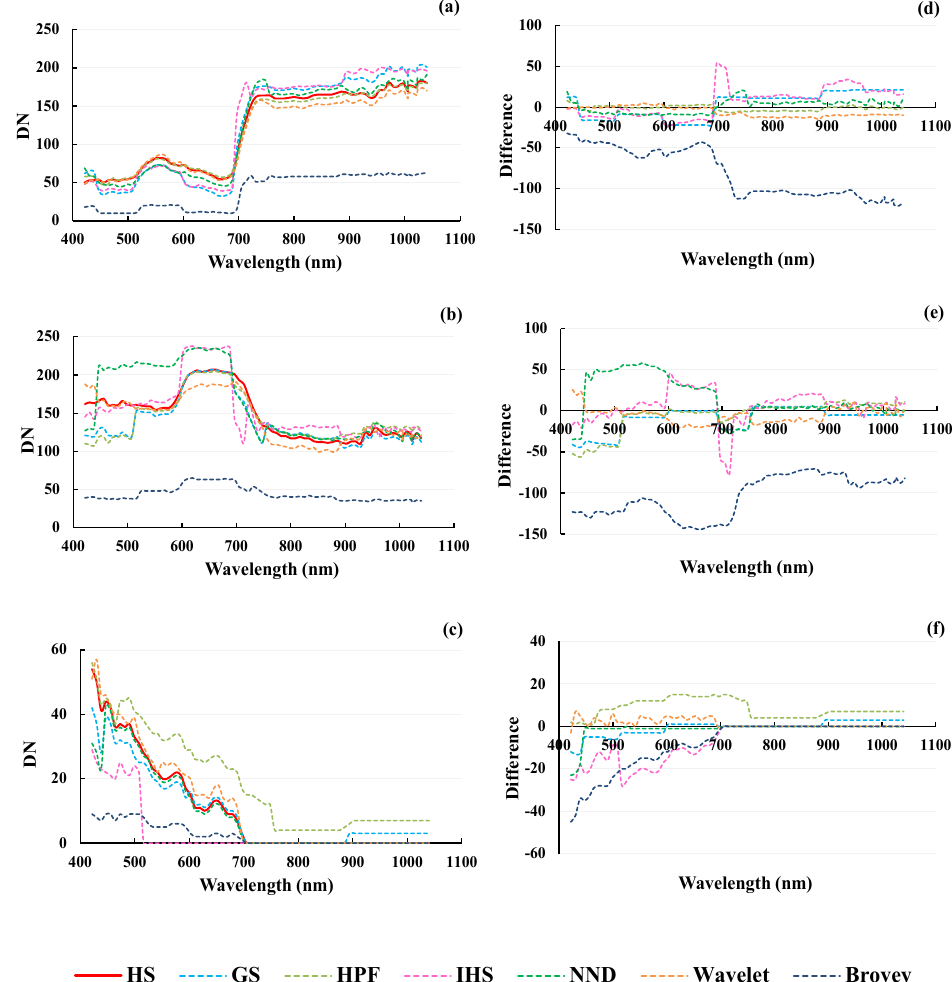
Figure 8. Spectral curves of typical objects. Top: vegetation spectral curves of six fused images and HS image ( a ), difference between fused images and HS image in vegetation spectral curve ( d ); Middle: artificial building spectral curves of six fused images and HS image ( b ), difference between fused images and HS image in building spectral curve ( e ); Bottom: water spectral curves of six fused images and HS image ( c ), difference between fused images and HS image in water spectral curve ( f ).